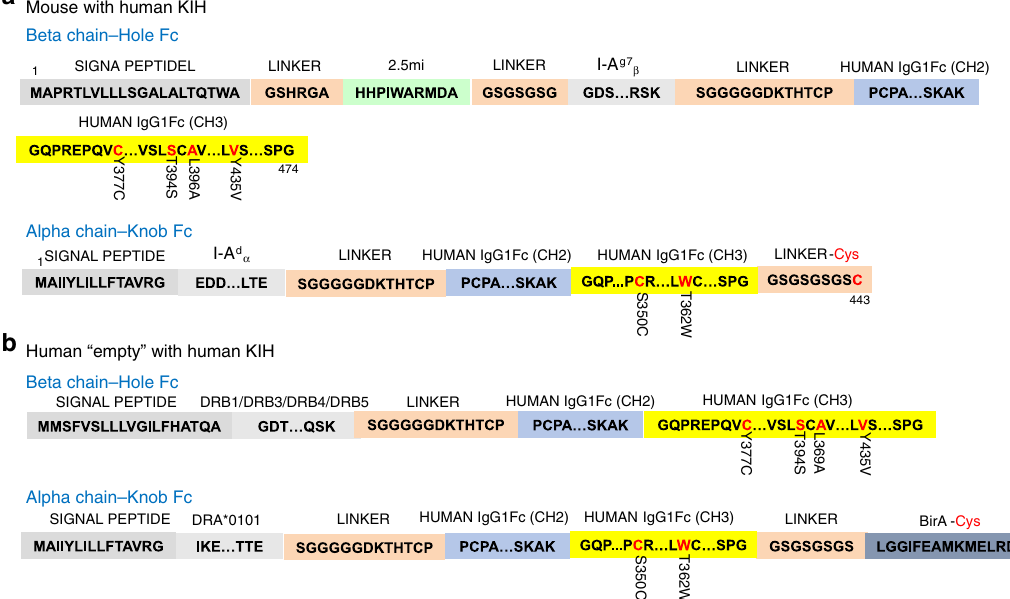
Fig. 3 Key junctional, linker and motif sequences for hKIH-based mouse pMHCII and empty hKIH-based human pMHCII. a Key amino acid sequences of